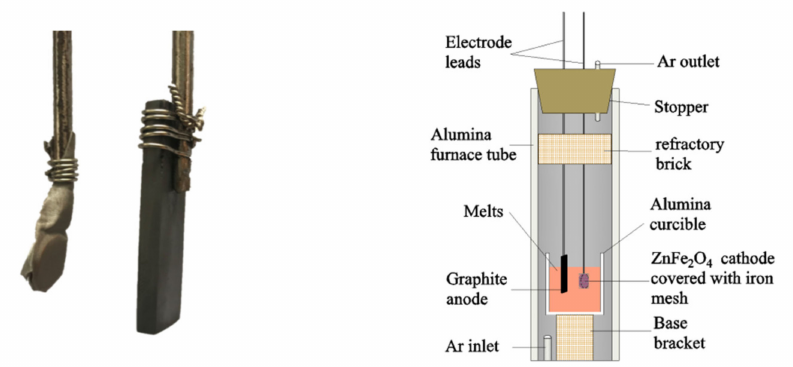
Figure 2. Physical picture of electrode and schematic diagram of electrolysis